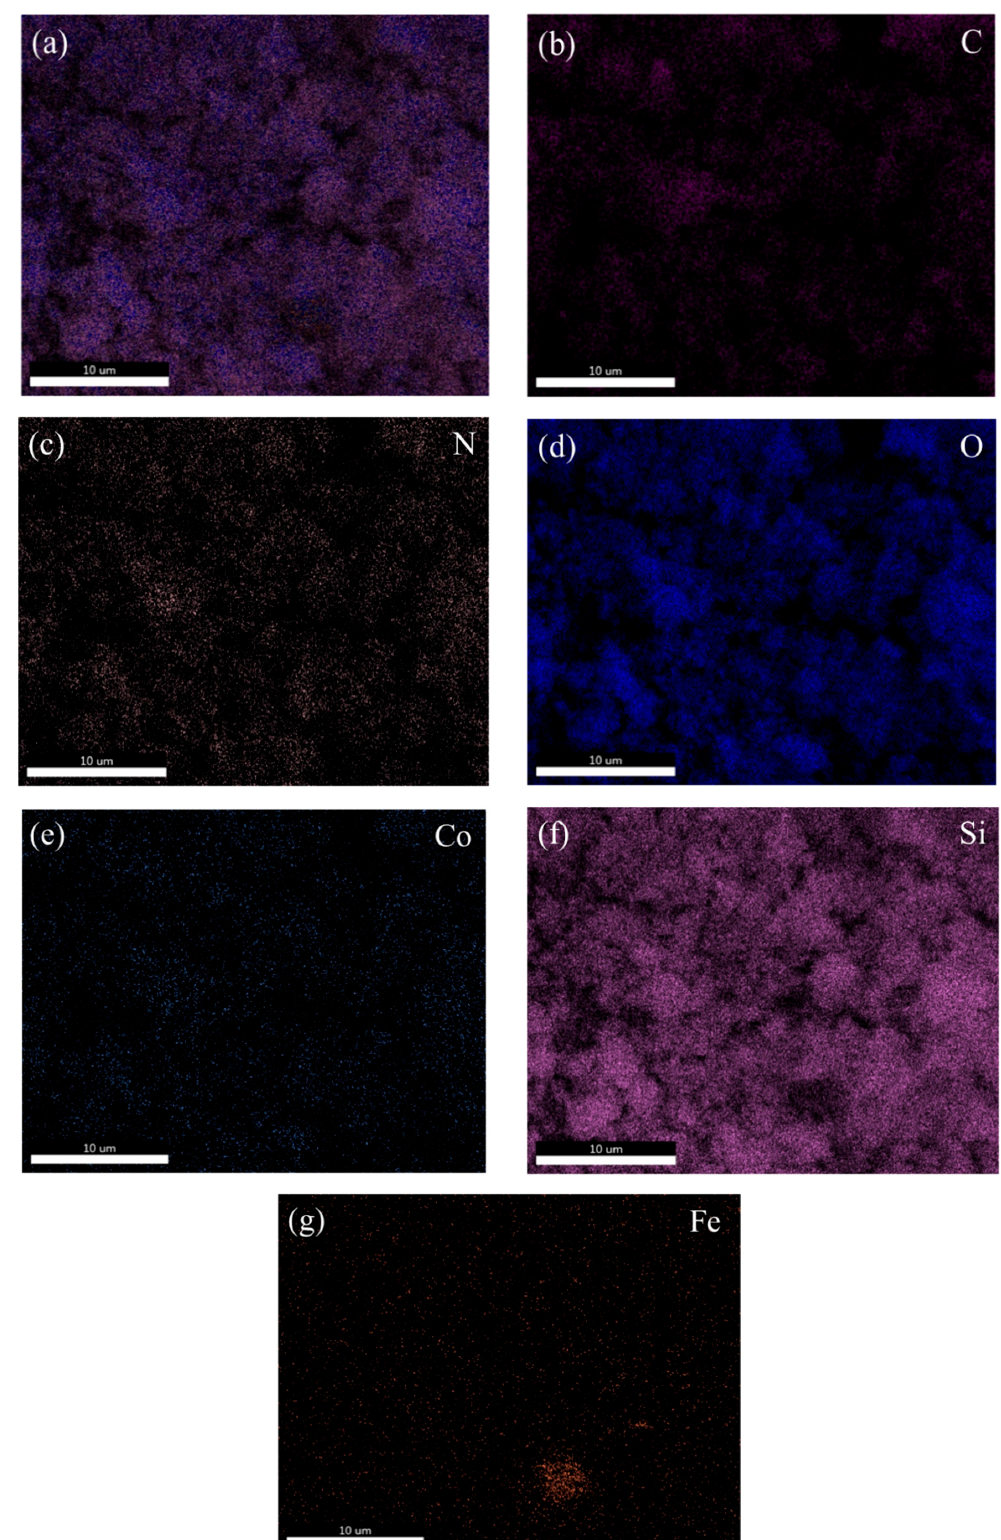
Figure 3. SEM image of CoFe 2 O 4 @SiO 2 -EDTA ( a ); EDS mappings of C ( b ), N ( c ), O ( d ), Co ( e ), Si ( f ) and Fe ( g ) of CoFe 2 O 4 @SiO 2